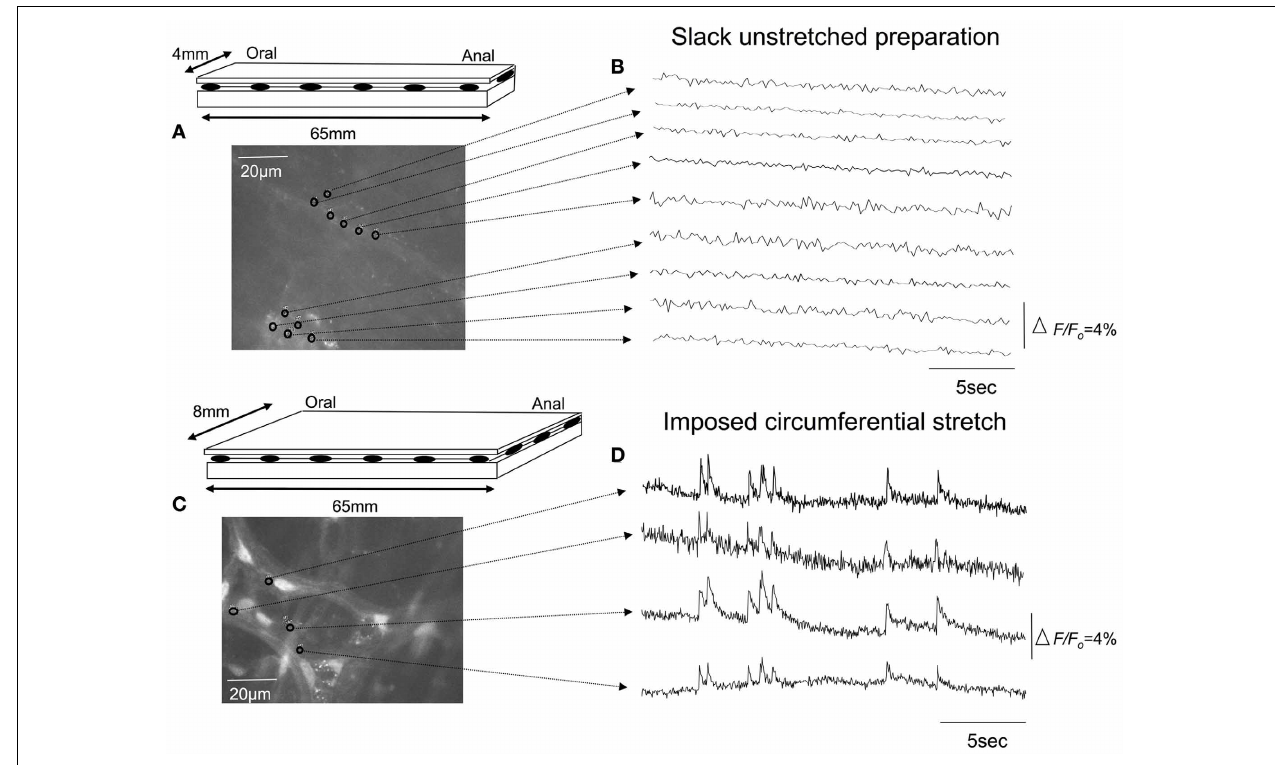
FIGURE 2 | Effects of circumferential stretch on rectal afferent nerve endings. (A) Diagrammatic representation of the isolated full length colon. The preparation was pinned unstretched, to a resting circumferential diameter of 4mm and length (slack) of 65mm. (B) Shows calcium recordings from inactive regions of interest throughout myenteric ganglia. (C) In the